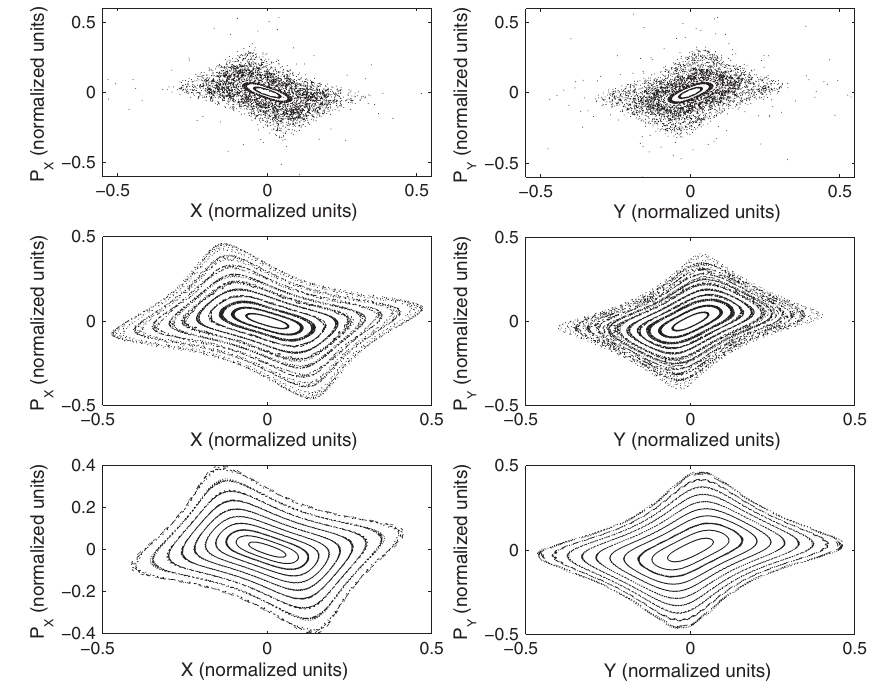
FIG. 4. Horizontal (left) and vertical (right) phase spaces for 3 different beta ratios B : B (cid:4) 10 (top), B (cid:4) 58 (middle), B (cid:4) 260 (bottom).